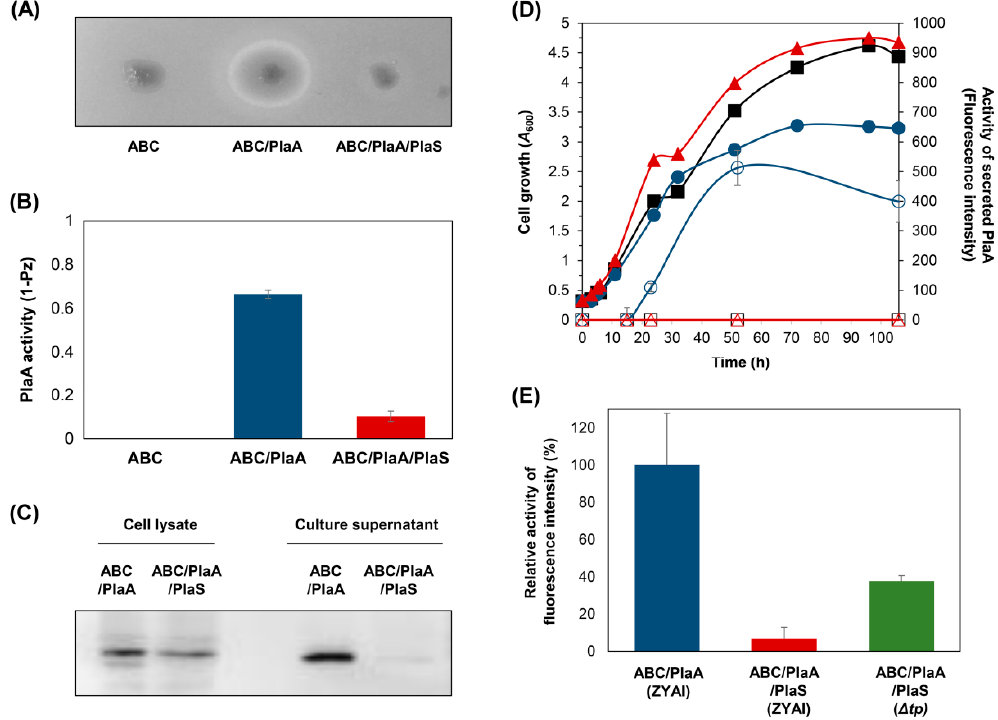
Figure 3. PlaA secretion by the ABC transporter system in P. fluorescens . ( A ) Each cell was grown on the lecithin plate at 25 ◦ C for four days. ( B ) PlaA activity was quantified by measuring the diameter of the halo zones around colonies on the lecithin plate. ( C ) Western blot analysis of PlaA from the samples of cell lysates and culture supernatants. The cells were cultured in M9 medium for four days with 1 mM Isopropyl β -D-1-thiogalactopyranoside (IPTG) added at A 600 = 0.8. ( D ) Growth curves of P. fluorescens ZYAI harboring di ff erent plasmids and activity of secreted PlaA, ABC ( (cid:4) and (cid:3) ), ABC / PlaA ( • and ABC / PlaA / PlaS ( (cid:78) and (cid:52) ). The cells were cultured in M9 media with 1 mM IPTG added at A 600 = 0.8. The PlaA activity was measured using PED-A1, fluorogenic substrate specific for PlaA in the culture supernatant. ( E ) The relative activity of PlaA, ABC / PlaA, and ABC / PlaA / PlaS was measured using the fluorescence substrate PED-A1 with the activity of ABC / PlaA set at 100%. The plasmids shown in Figure 1 were used for the experiments. All experiments were performed with P. fluorescens ZYAI except ABC / PlaA / PlaS, the activity of which was compared in both P. fluorescens ∆ tp and P. fluorescens ZYAI. Error bars represent the standard deviation from three independent